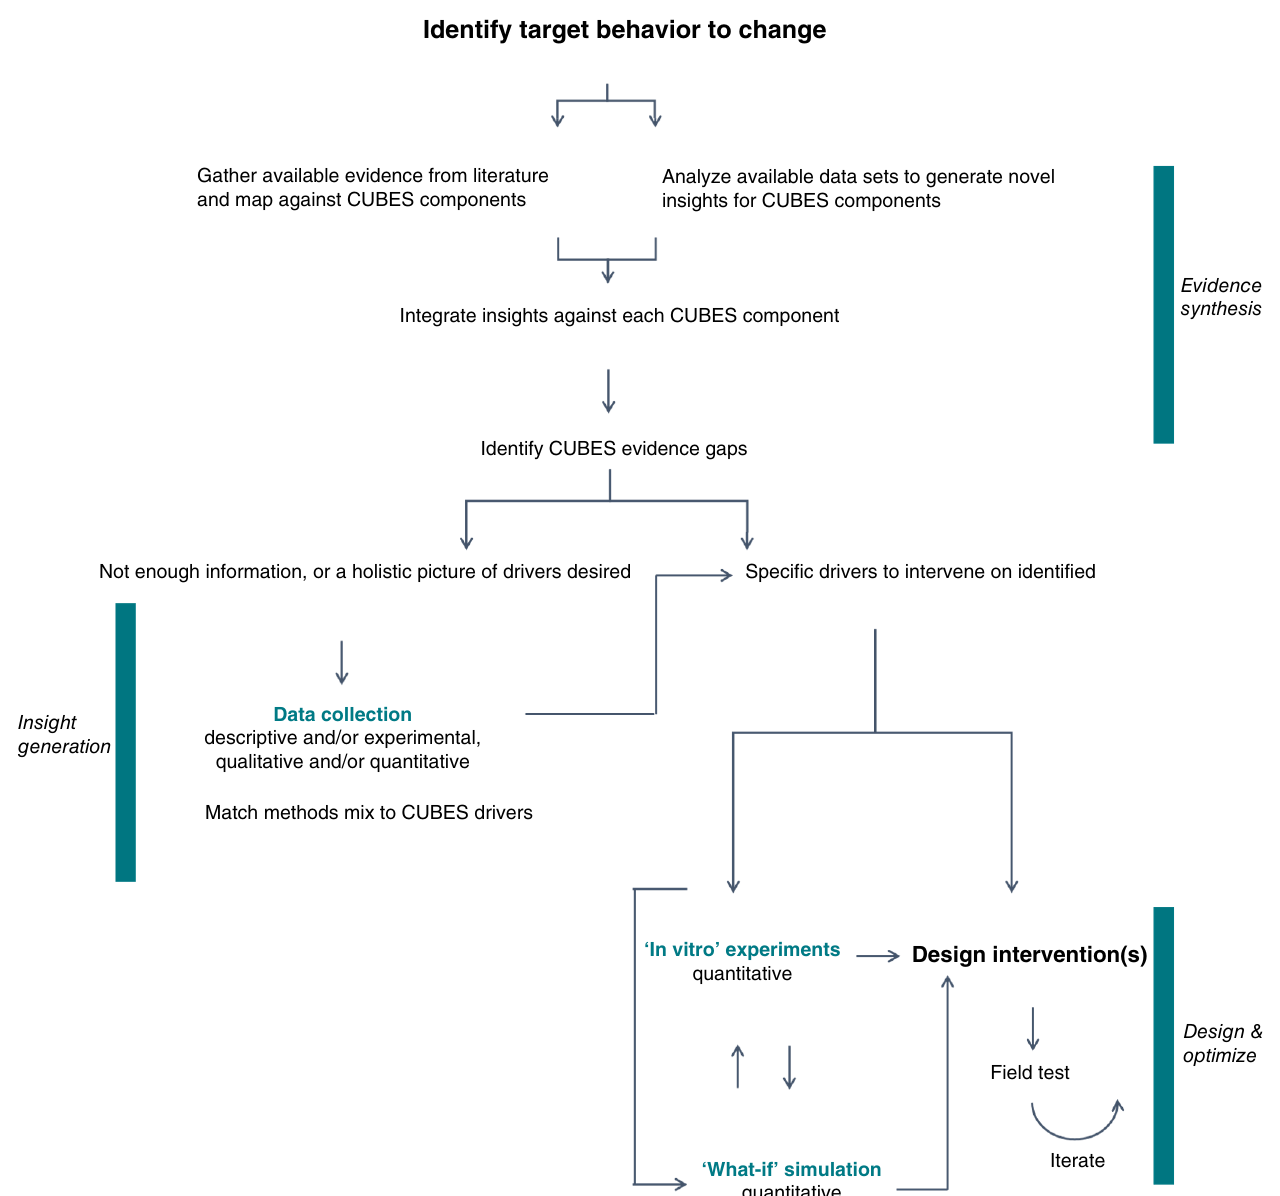
Figure 2. Decision aid for choosing the right research approach at the right time, for the right purpose.